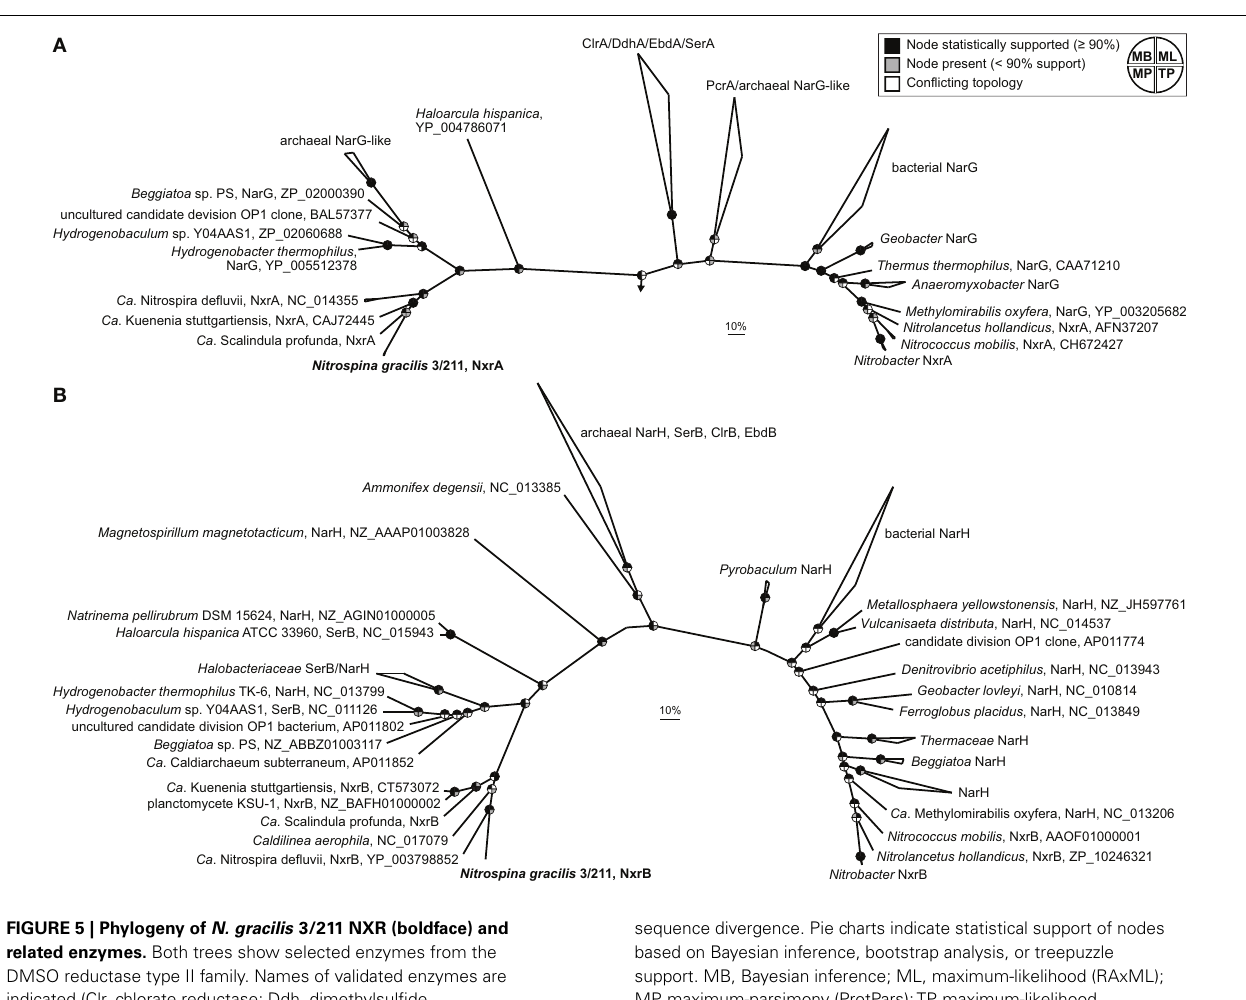
FIGURE 5 | Phylogeny of N. gracilis 3/211 NXR (boldface) and related enzymes. Both trees show selected enzymes from the DMSO reductase type II family. Names of validated enzymes are indicated (Clr, chlorate reductase; Ddh, dimethylsulfide dehydrogenase; Ebd, ethylbenzene dehydrogenase; Nar, Nitrate reductase; Nxr, nitrite oxidoreductase; Pcr, perchlorate reductase; Ser, selenate reductase). More distantly related molybdoenzymes were used as outgroup.The scale bar represents 10% estimated